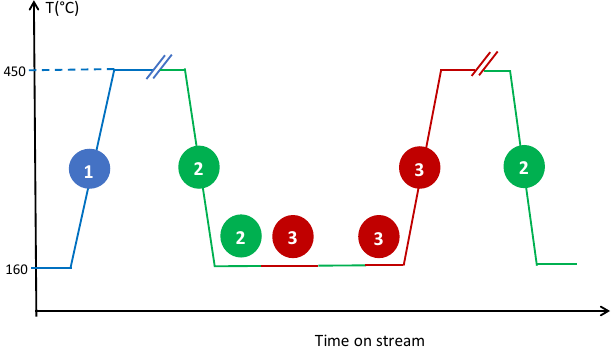
Figure 1. Protocol used for temperature-programmed and steady-state rate measurements.